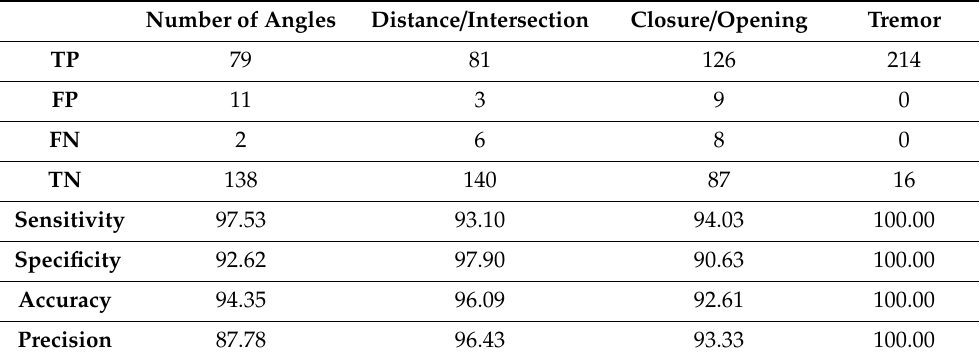
Table 5. Performance of the scoring parameters in the